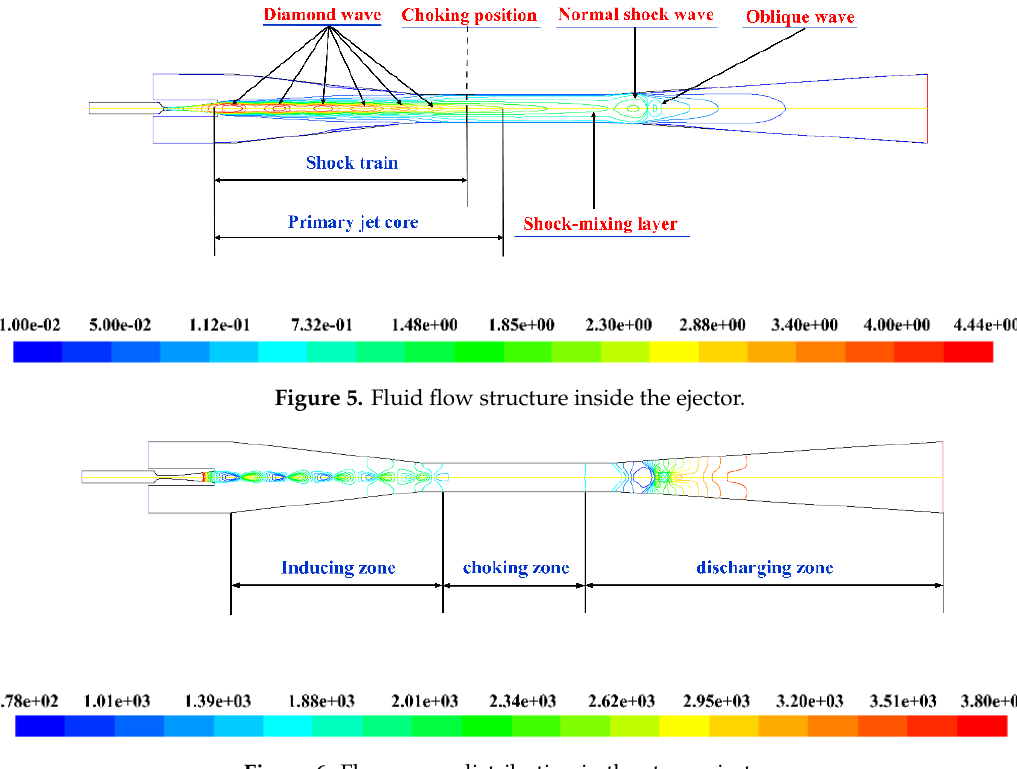
Figure 6. Flow zones distribution in the steam ejector.